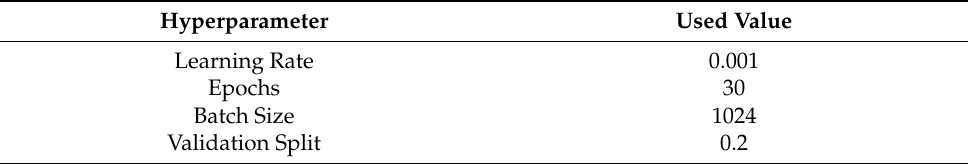
Table 2. Neural Network used